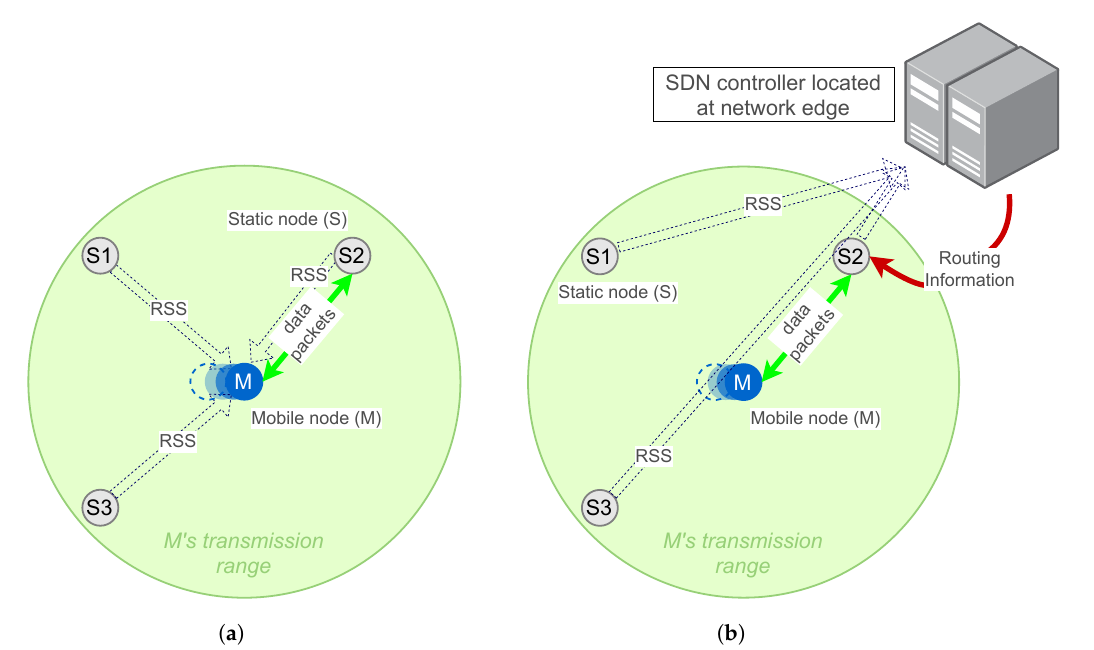
Figure 1. Illustration of mobility management strategies—( a ) Distributed strategy—Mobile node ( M ) does the routing function by processing the Received Signal Strength ( RSS ) values from neighbouring Static nodes ( S ); and ( b ) Centralized strategy—SDN controller at network edge picks the next best parent for M to relay data